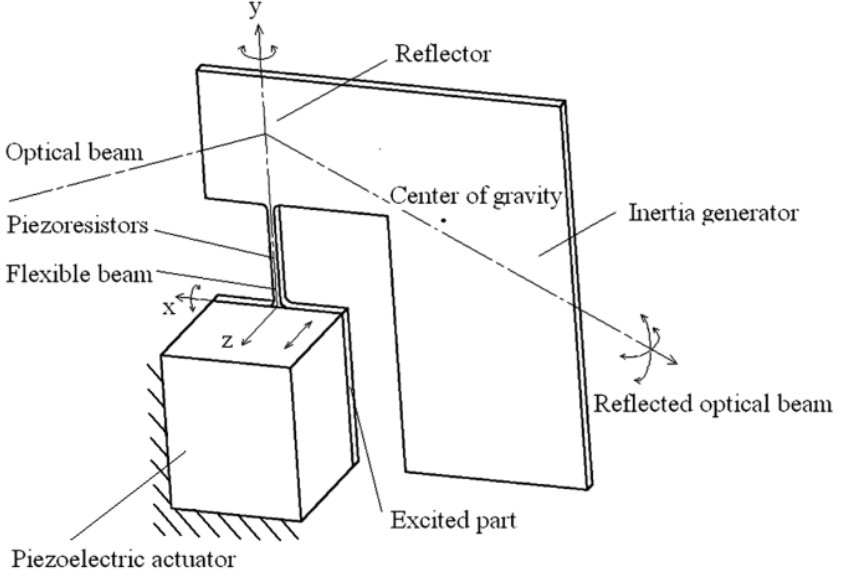
Figure 1. Structure of the two-dimensional scanning micro-mirror.